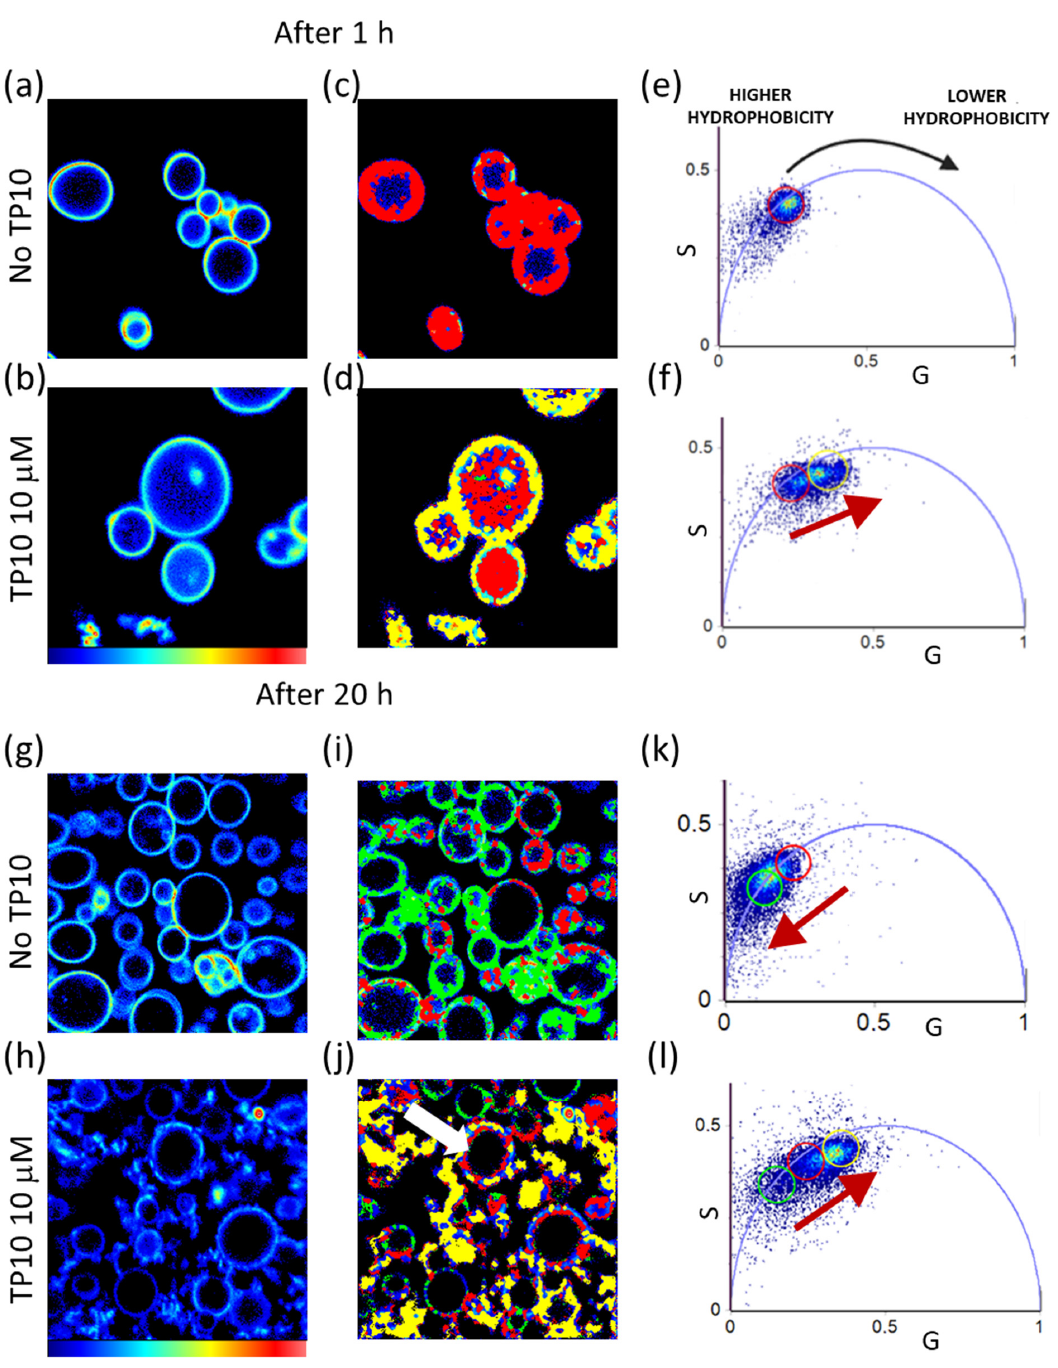
Figure 4. Phasor analysis of 256 × 256 pixels FLIM measurements from NR ( λ exc = 540 nm, range 580–700 nm) in GPMVs. Measurements acquired 1 h and 20 h after the addition of 10 µ M TP10 are reported. ( a ) Fluorescence intensity map of a representative control measurement from NR-stained GPMVs in the absence of TP10. ( b ) Fluorescence intensity map for NR-stained GPMVs 1 h after the addition of 10 µ M TP10. ( c , d ) Corresponding lifetime maps from the selection in the phasor plots in ( e , f ), respectively. ( g ) Fluorescence intensity map of a representative control measurement at the 20-h time point on NR-stained GPMVs in the absence of TP10. ( h ) Fluorescence intensity map for NR-stained GPMVs 20 h after the addition of 10 µ M TP10. ( i , j ) Corresponding lifetime maps from the selection in the phasor plots in ( k , l ), respectively. Green, red, and yellow cursors are used to select different lifetime distributions and are kept in the same